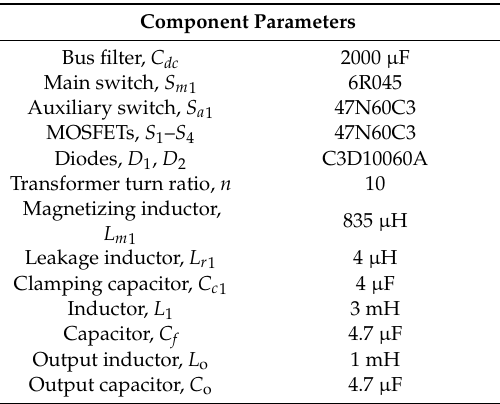
Table 2. Component parameters of the proposed